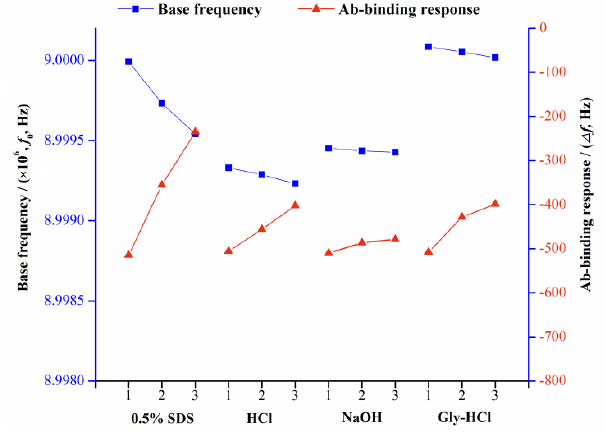
Figure 4. Results for the base frequency and Ab-binding response obtained using various regenera- tion solutions. The number on the X -axis represents the analysis cycle.